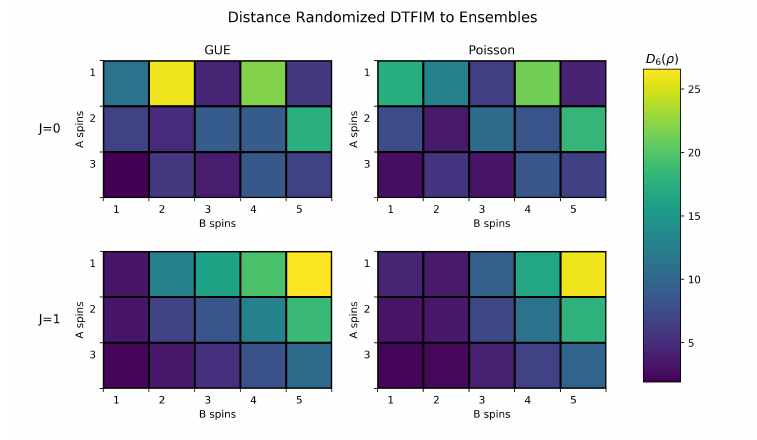
Figure 23: Left: Normalized distance of dynamics of Disordered Transverse Field Ising Model (see equation 43) to analytical GUE. Right: to analytical Poisson.